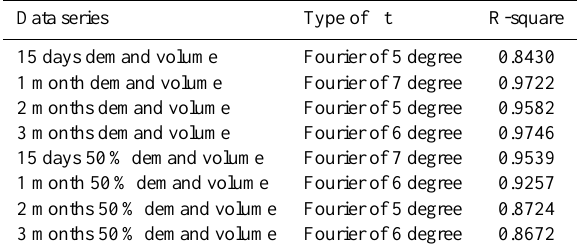
Table 1. Types of fit and goodness of fit for each density probability function of the final state of the reservoir compared to its initial state.